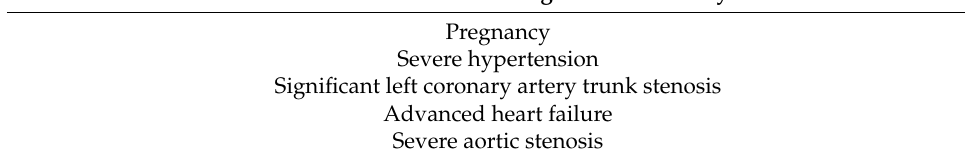
Table 3. Contraindications to the provocation test